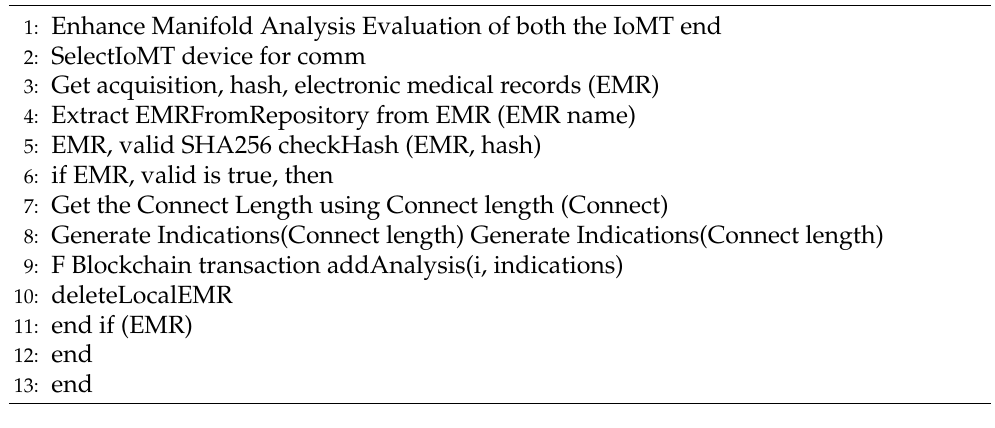
Algorithm 2 Algorithm Method Evaluation